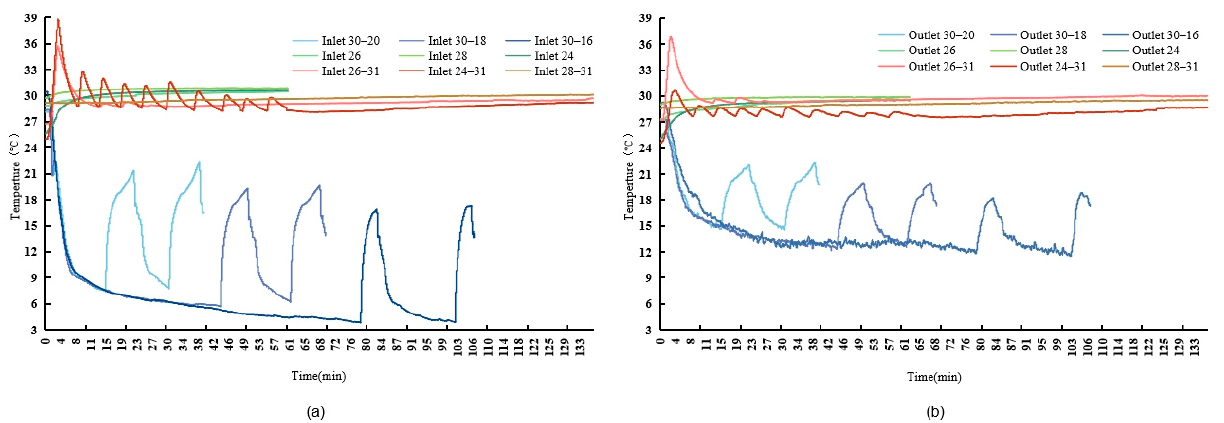
Figure 12. Average temperature distributions of the air supply and air outlet. ( a ) The average temperature distribution of the inlet. ( b ) The average temperature distribution of the outlet.